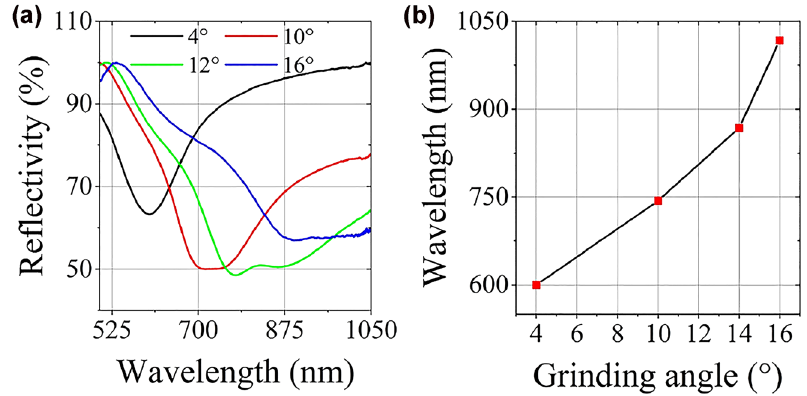
Figure7: Sensorperformanceforthesensing surface with different grinding angels: 4 ◦ , 10 ◦ , 12 ◦ , 16 ◦ . The analyte is water with RI of 1.332: (a) SPR spectra; (b) resonance